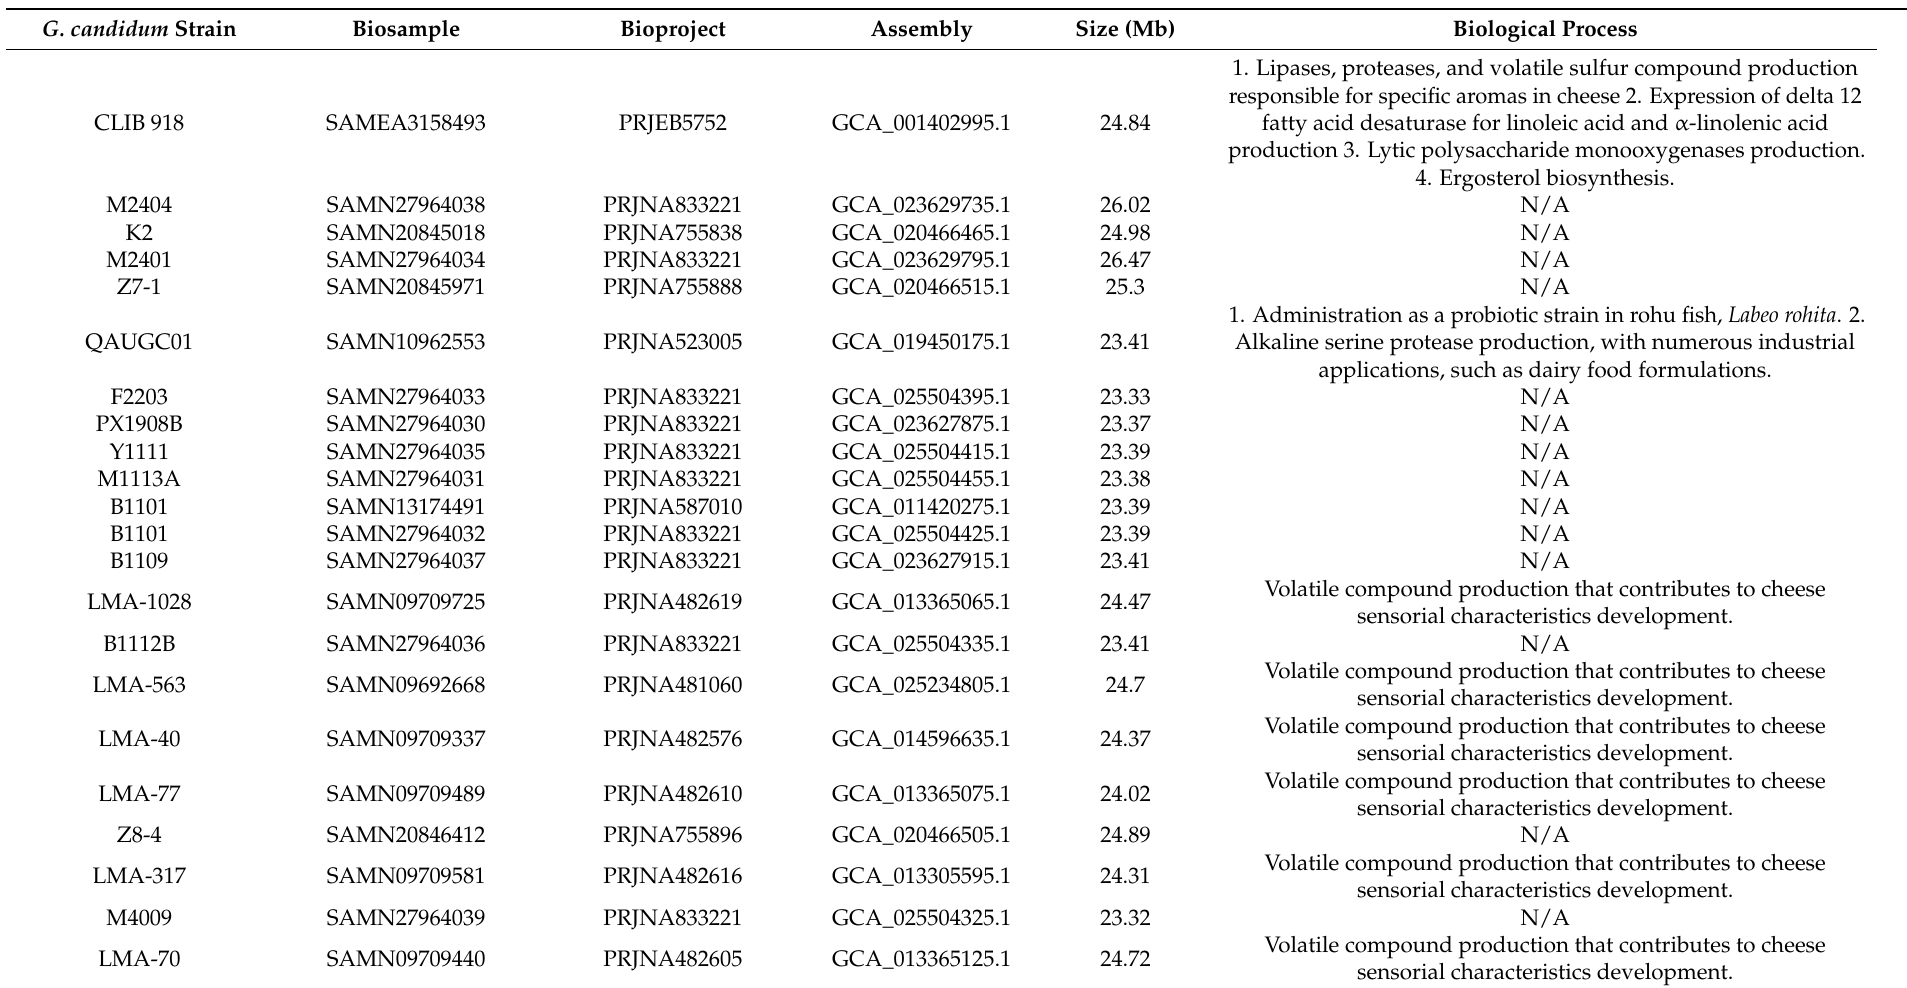
Table 1. List of the assembled and annotated and/or 16S rRNA gene-sequenced G. candidum strains, the genome size, and possible industrial